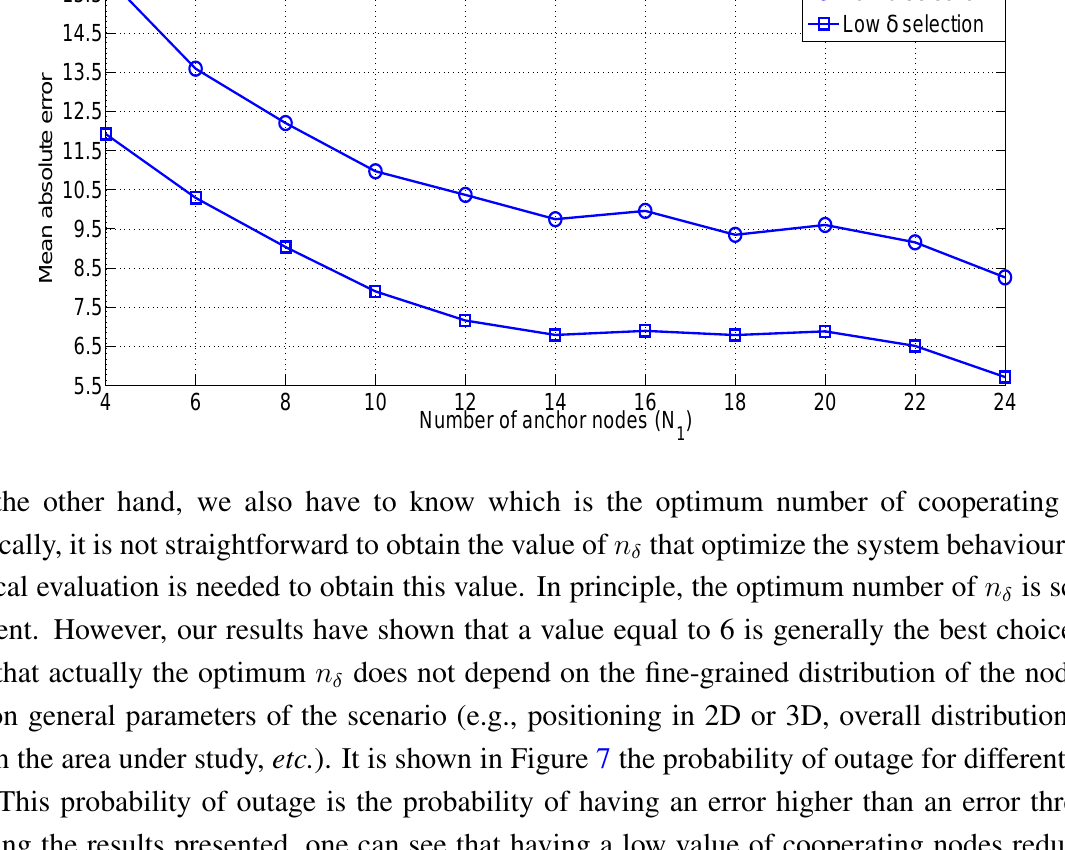
Figure 6. Mean absolute error versus number of anchor nodes ( N 1 ) ( n δ = n α = 6 ).